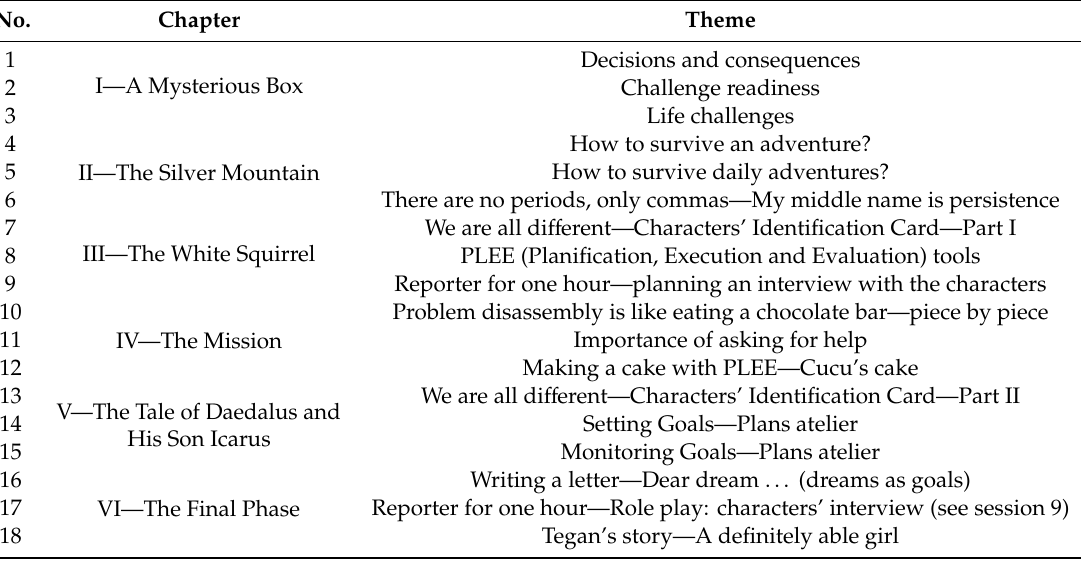
Table A1. Session-by-session intervention program